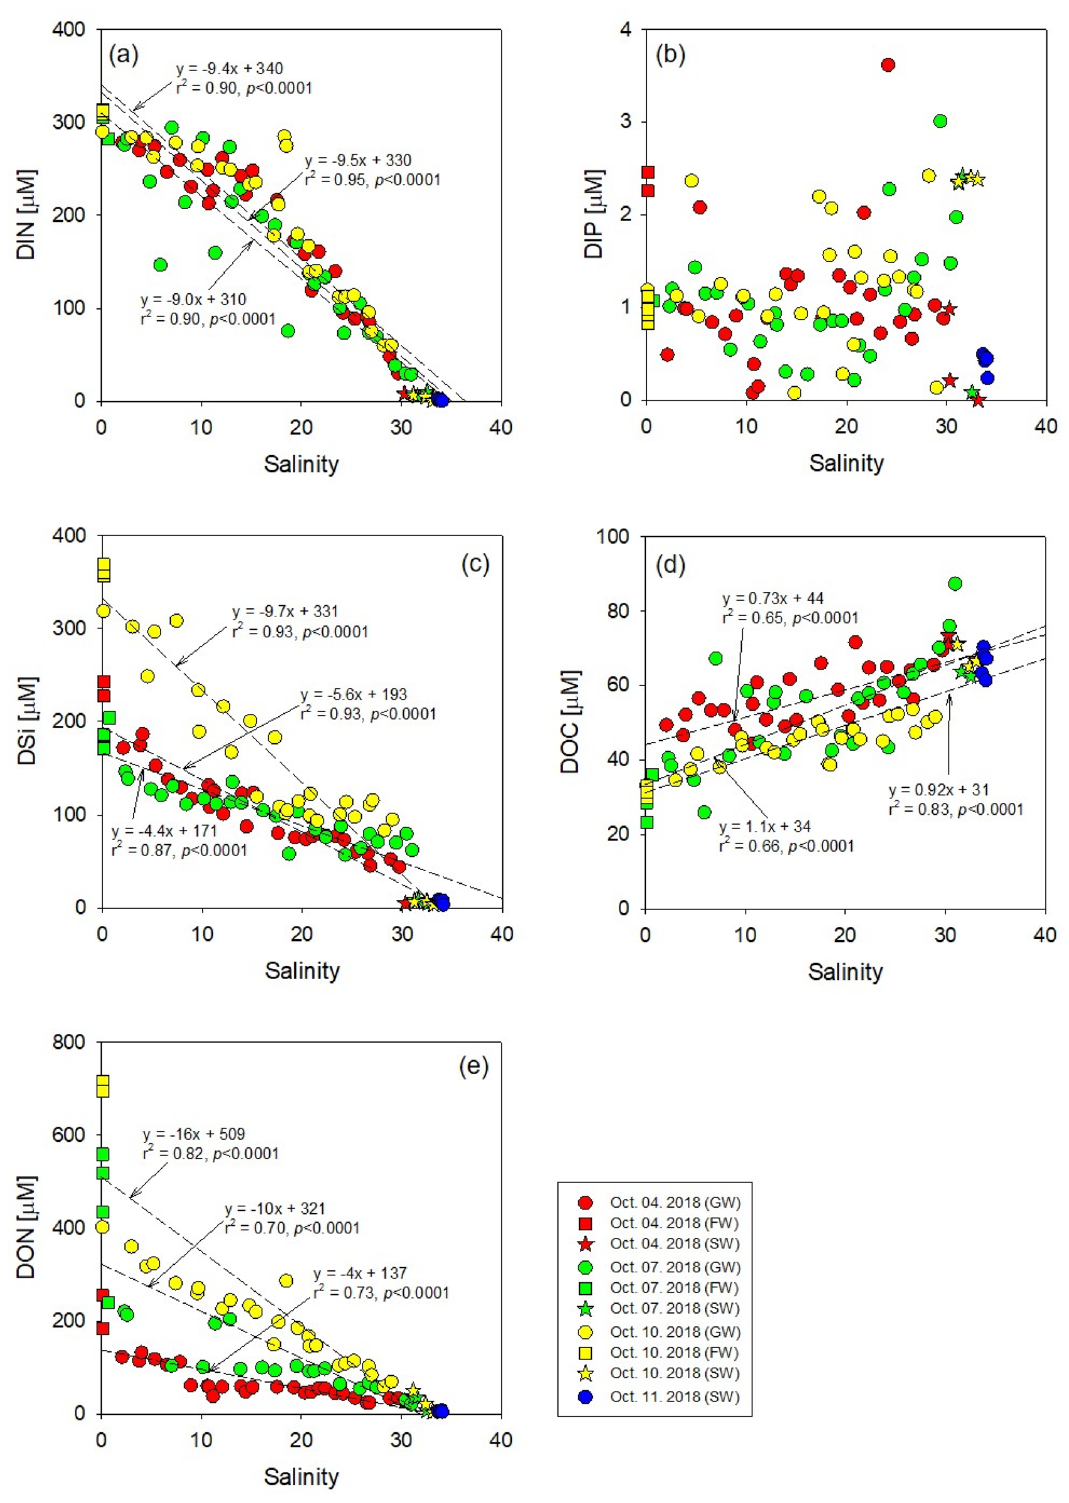
Figure 1. Scatter plots of ( a ) dissolved inorganic nitrogen (DIN), ( b ) dissolved inorganic phosphorus (DIP), ( c ) dissolved silicon (DSi), ( d ) dissolved organic carbon (DOC), and ( e ) nitrogen (DON) versus salinity in Hwasun Bay. Red, green, and yellow dots indicate samples collected on October 4, 2018 (before the typhoon), October 7, 2018 (one day after the typhoon), and October 10, 2018 (4 days after the typhoon) in Hwasun Bay. This figure was drawn with sigma plot software (ver.